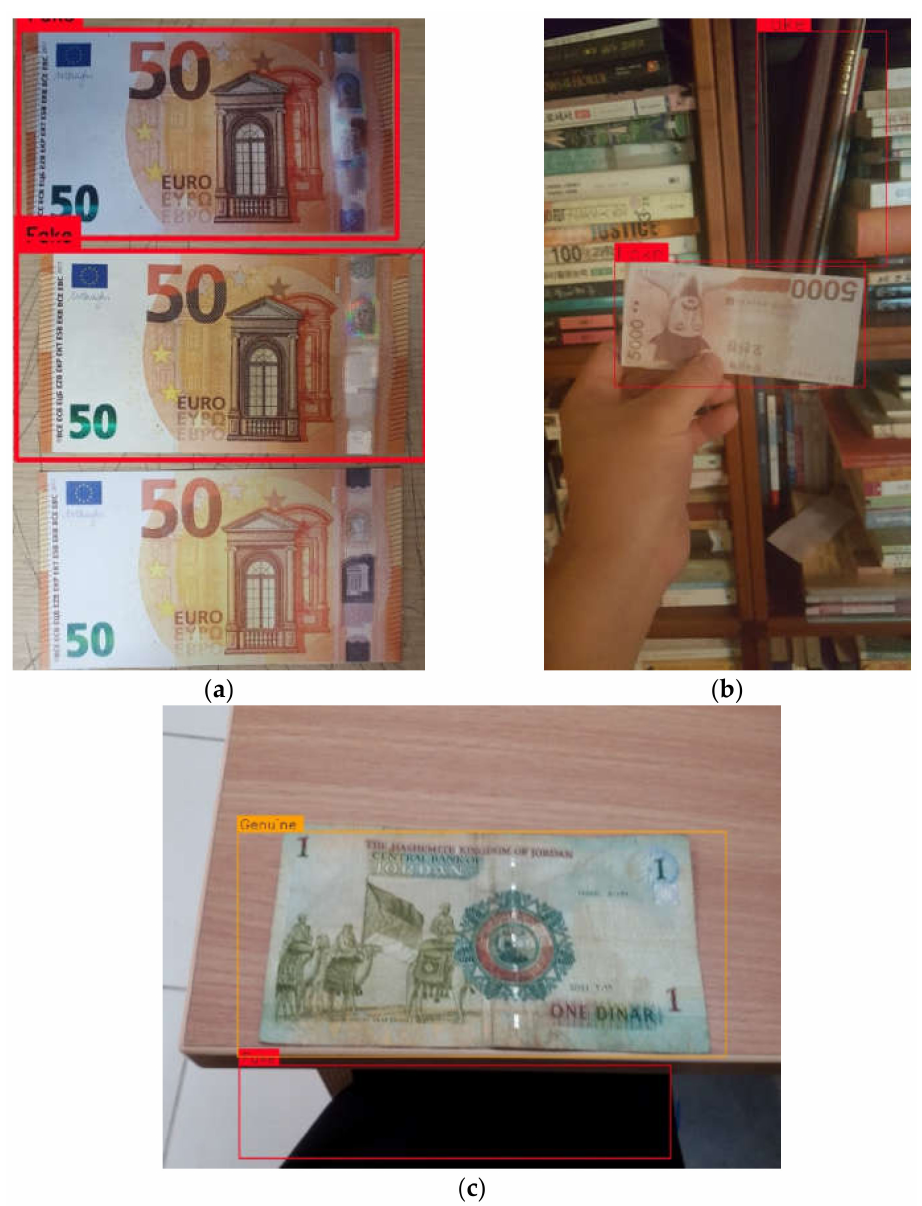
Figure 21. Error cases of ( a ) EUR, ( b ) KRW, and ( c ) JOD banknote images using the models trained on the USD dataset for